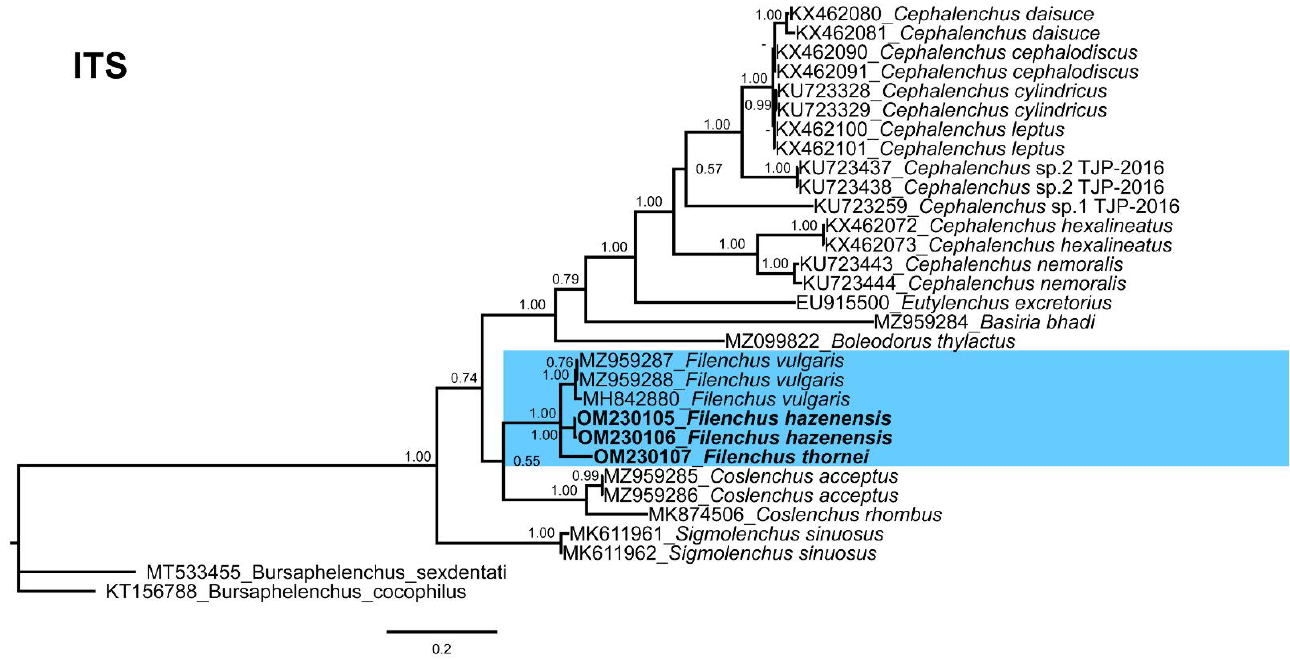
Figure 7. Phylogenetic relationships of the Canadian population of Filenchus species with related Tylenchidae species. Bayesian 50% majority rule consensus tree as inferred from ITS sequence alignment under the general time-reversible model with a gamma-shaped distribution (GTR + G). Posterior probabilities of greater than 0.70 are given for appropriate clades. The sequences produced in this study are shown in bold, and the colored box indicates the clade association of the recovered Filenchus species.